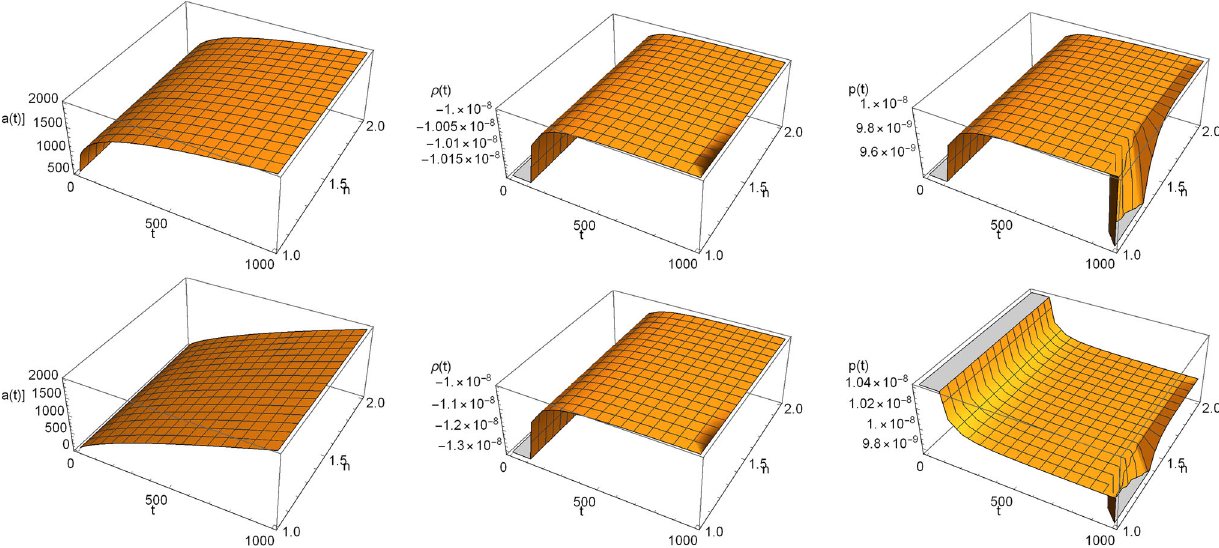
Fig. 5 The evolution of the scale factor a ( t ) , density ρ( t ) and pressure p ( t ) for typical values of q = 0 . 2 in the upper plot and q = 0 . 8 in the lower plot. We have set a s = 2000 , a ES = 0 . 01 , t s = 1000 , λ =